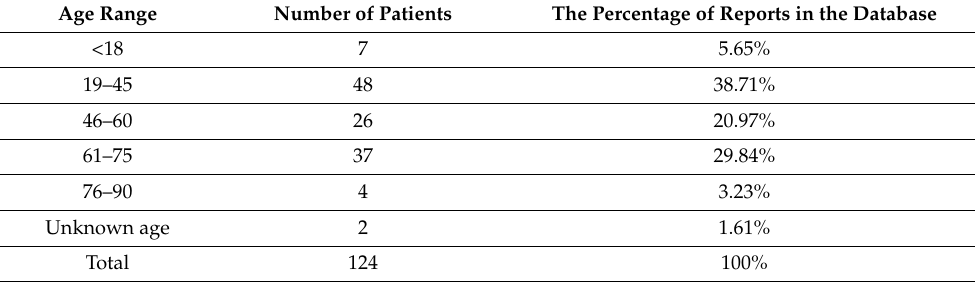
Table 1. Characteristics of patients group.